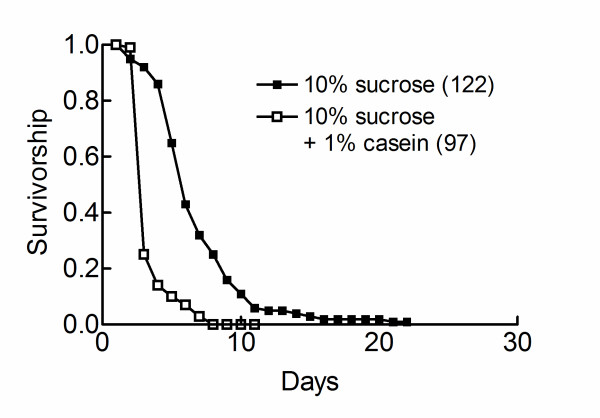
Casein decreases the longevity of sima loss of function mutants. Sima07607/07607 flies were raised under normoxic conditions. Newly emerged adults were shifted to chronic hypoxic conditions and maintained either on a pure 10% sucrose diet or a 10% sucrose diet supplemented with 1% casein and survivorship curves were determined. Sample sizes are indicated in parentheses. Survivorship curves were compared using the log-rank test. P was < 0.0001. Corresponding survivorship curves for w1118 flies are presented in Figure 1C.